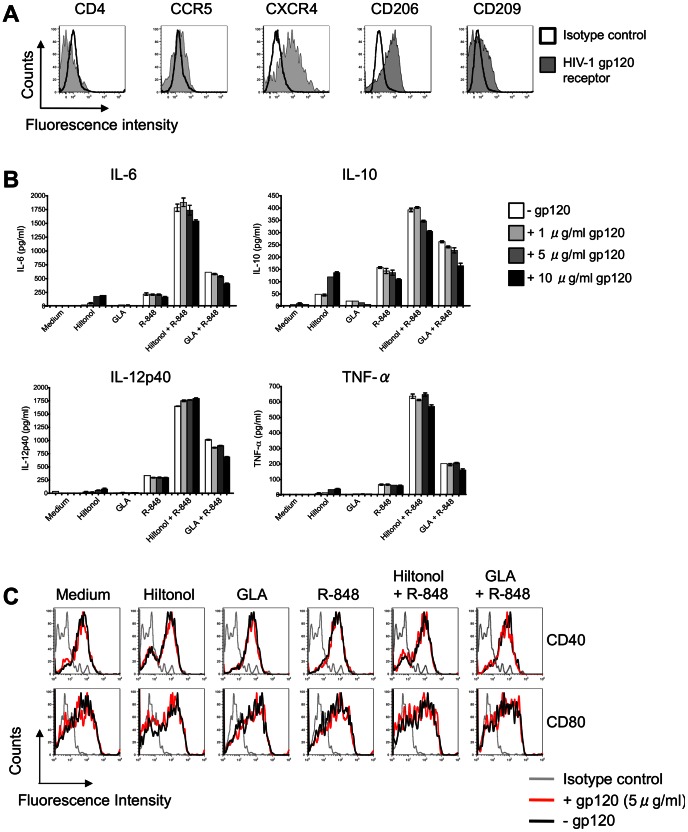
HIV-1 gp120 does not compromise the capacity of selected TLR ligand combinations to activate CD14+ DDCs.(A) Expression of gp120-binding receptors by CD14+ DDCs. Migratory cells were stained for MAbs specific for the following gp120-binding receptors: CD4, CCR5 (CD195), CXCR4 (CD184), CD206 and CD209, after gating on CD14+ HLA-DR+ DDCs. The data are representative of three independent experiments. The black open histograms represent the isotype controls. (B) Cytokine secretion by CD14+ DDCs in response to TLR ligand(s) and gp120. CD14+ DDCs were exposed to different concentrations of JR-FL gp120 (1–10 µg/ml) for 1 h at 37°C before adding TLR ligand(s) for 48 h. The following concentrations were used: Hiltonol (10 µg/ml), GLA (500 ng/ml) and R-848 (2.5 µg/ml). IL-6, IL-10, IL-12p40 and TNF-α were quantified in supernatants by ELISA. The data are representative of three independent experiments and are presented as means ± SEM of duplicate samples. (C) Phenotype of CD14+ DDCs after stimulation with TLR ligand(s) in the presence or absence of HIV-1 gp120. The data are from one of three experiments performed. Gray histograms: isotype control; Open black histograms: CD14+ DDCs stimulated in the absence of gp120; Open red histograms: CD14+ DDCs stimulated in the presence of 5 µg/ml JR-FL gp120.